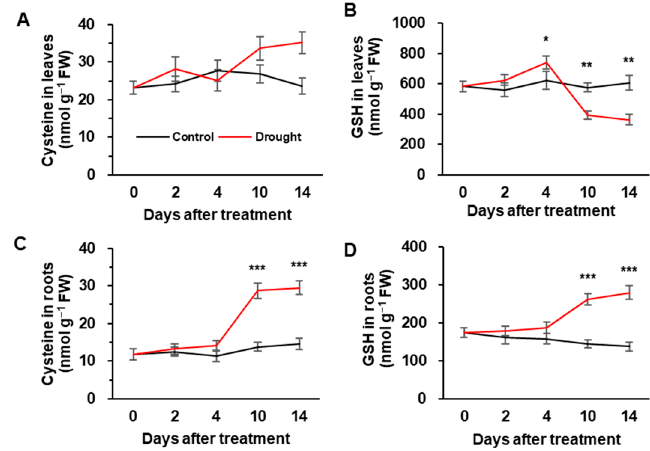
Figure 3. Changes in concentration of cysteine ( A , C ) and glutathione ( B , D ) in leaves ( A , B ) and roots ( C , D ) in well-watered (control) or drought-stressed plants for 14 days. The black and red lines indicate control and drought stress, respectively. Data are represented as means ± S.E. for n = 4. Asterisks indicate a significant difference between well-watered and drought-stressed plants: * p < 0.05, ** p < 0.01, *** p < 0.001.